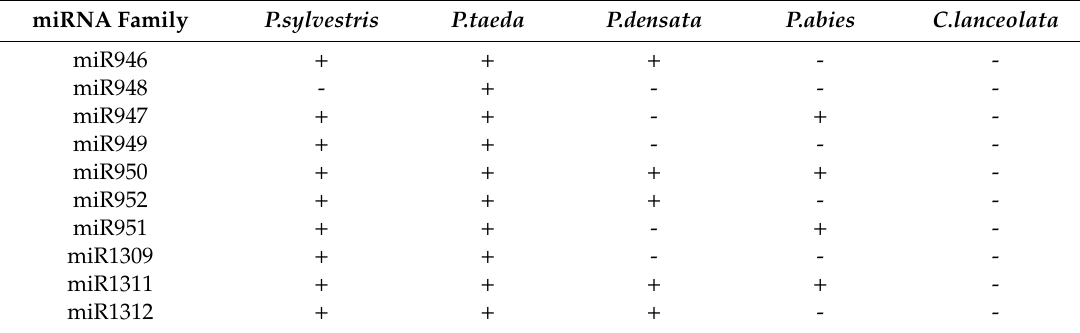
Table 3. miRNAs found only in conifers based on miRBase and Scots pine